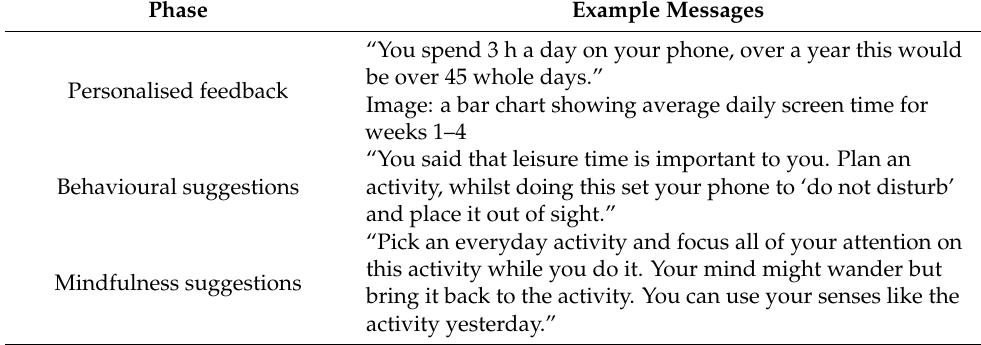
Table 2. Example intervention